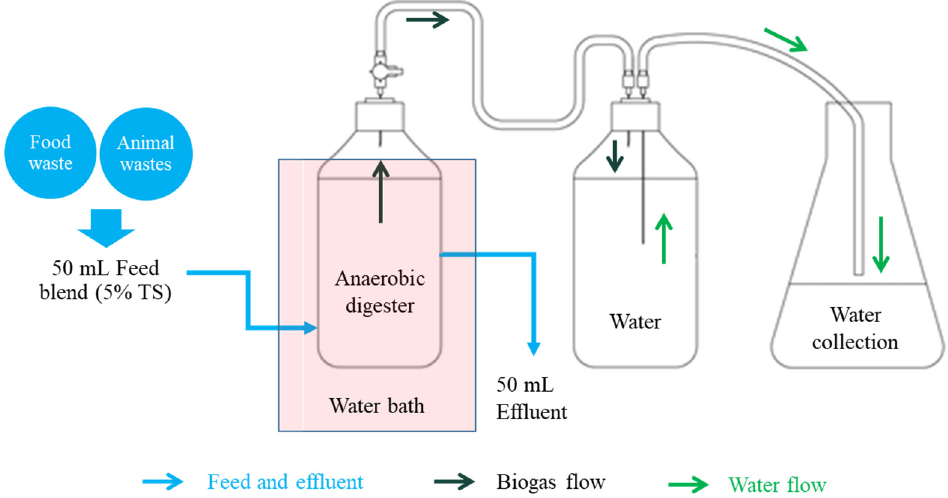
Figure 1. Setup of the bioreactor.